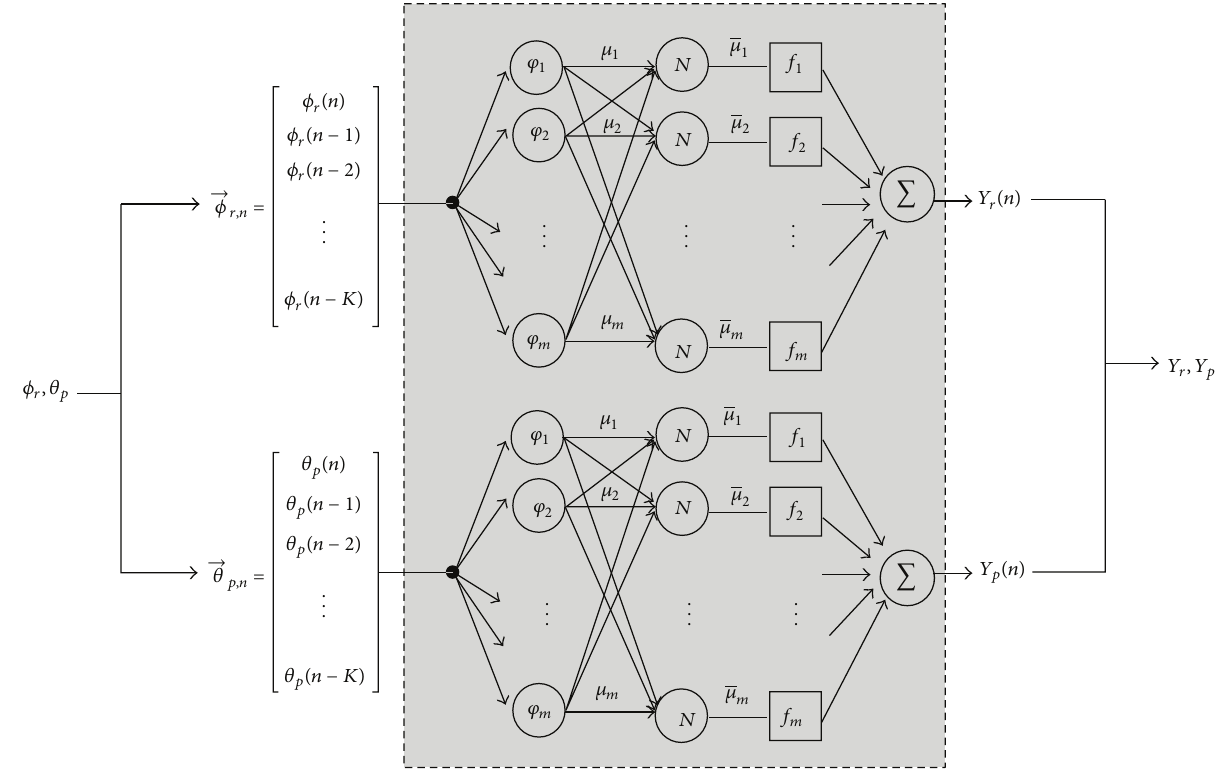
Figure 5: Parallel FBFN beam pointing error